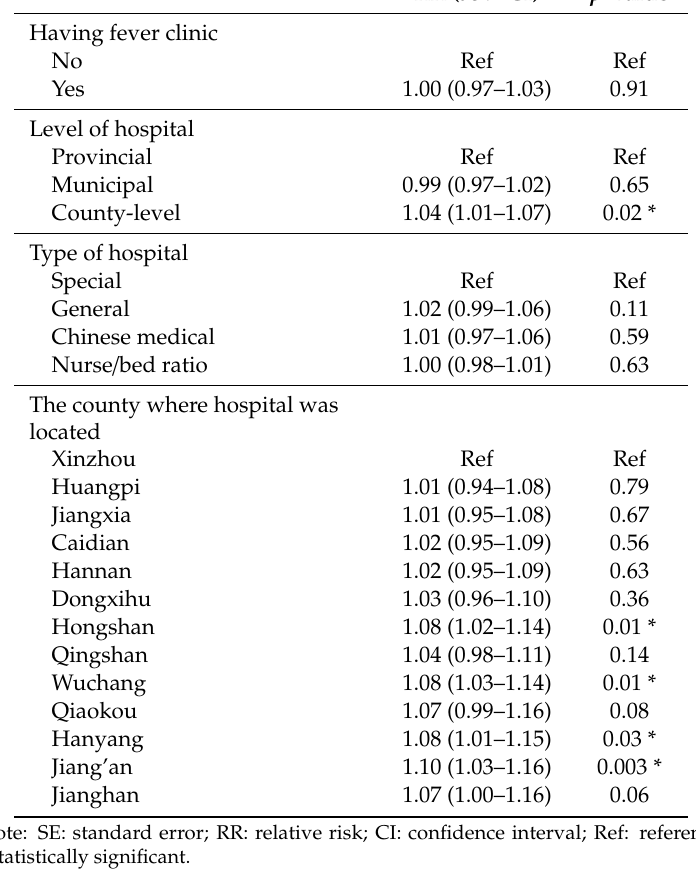
Table3. RiskfactorsforCOVID-19attackrateofmainhospitalsinWuhanbymultivariatelinearregression. RR (95% CI) p